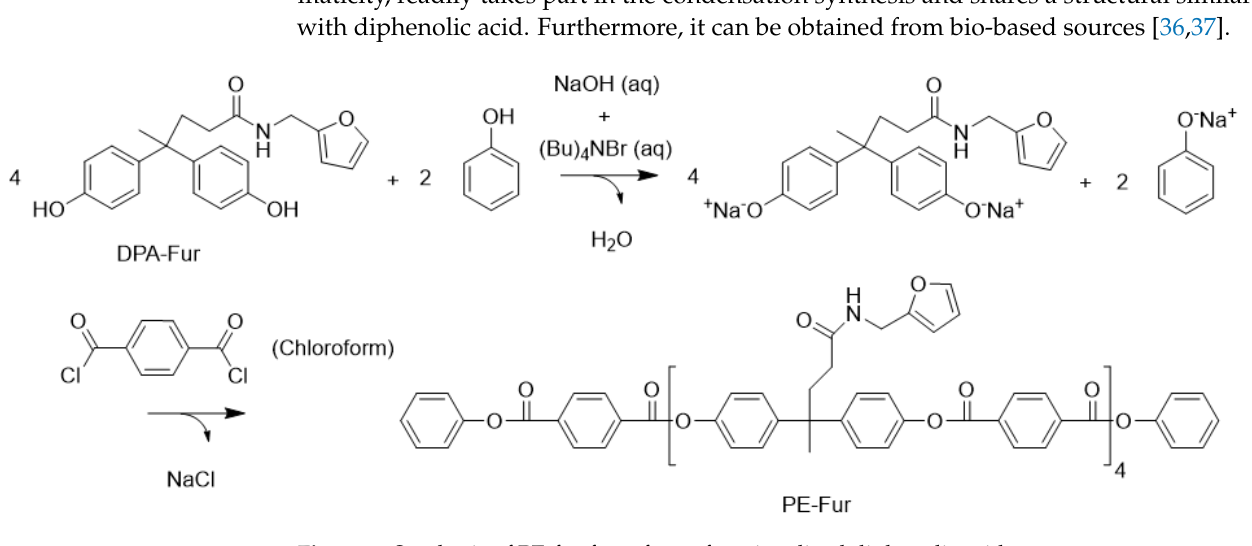
Figure 1. Synthesis of PE-fur from furan-functionalized diphenolic acid.